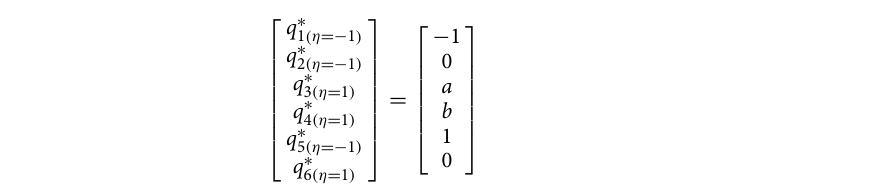
Figure 3. Influence of the scale of hybrid NPs under the